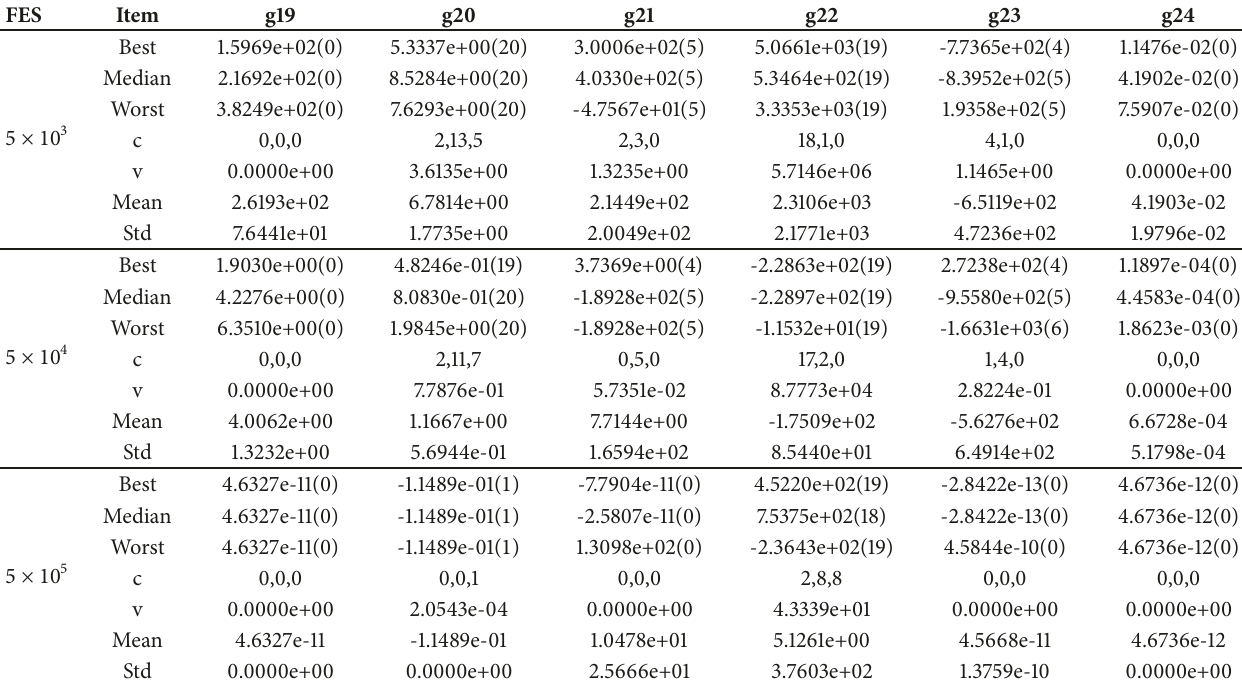
Table 5: General performance in terms of function error values achieved by CADE for test functions